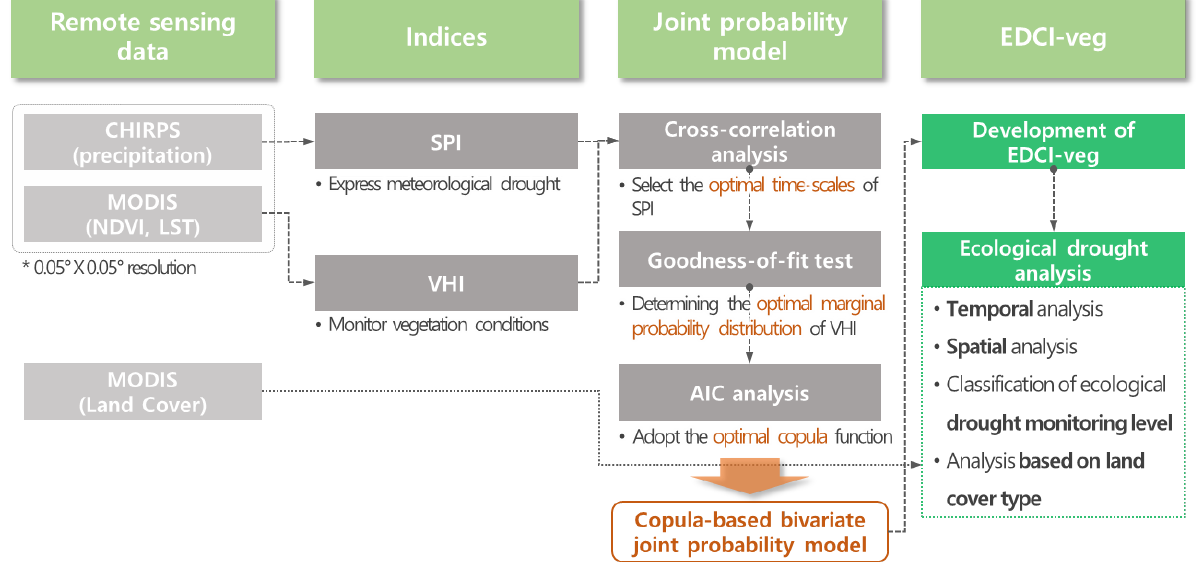
Figure 1. Flow chart; Asterisk (*) indicates the spatial resolution of the data.